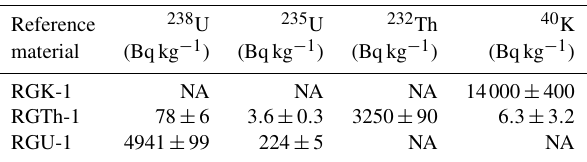
Table 3. Recommended radionuclide-specific activities as provided on the home page of the IAEA. All values are given in becquerels per kilogram (Bqkg − 1 ). Please note that only values for which in- formation is provided by the IAEA were considered for this table. Uncertainties represent the 95%